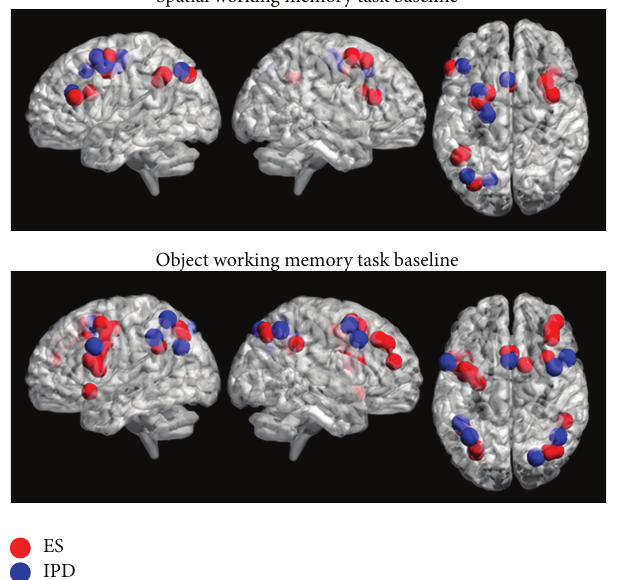
Figure 2: Image shows SPM within-group comparisons for the SWMT-SWMB and OWMT-OWMB contrasts. 3D reconstruction of SPM contrasts (BrainNet viewer [69]). Spherical ROIs depicting peaks of activation in Cluster extent of 𝑘 = 10 voxels; 𝑃 value < 0.001, uncorrected in all comparisons (see text for details on the stereotactic coordinates).